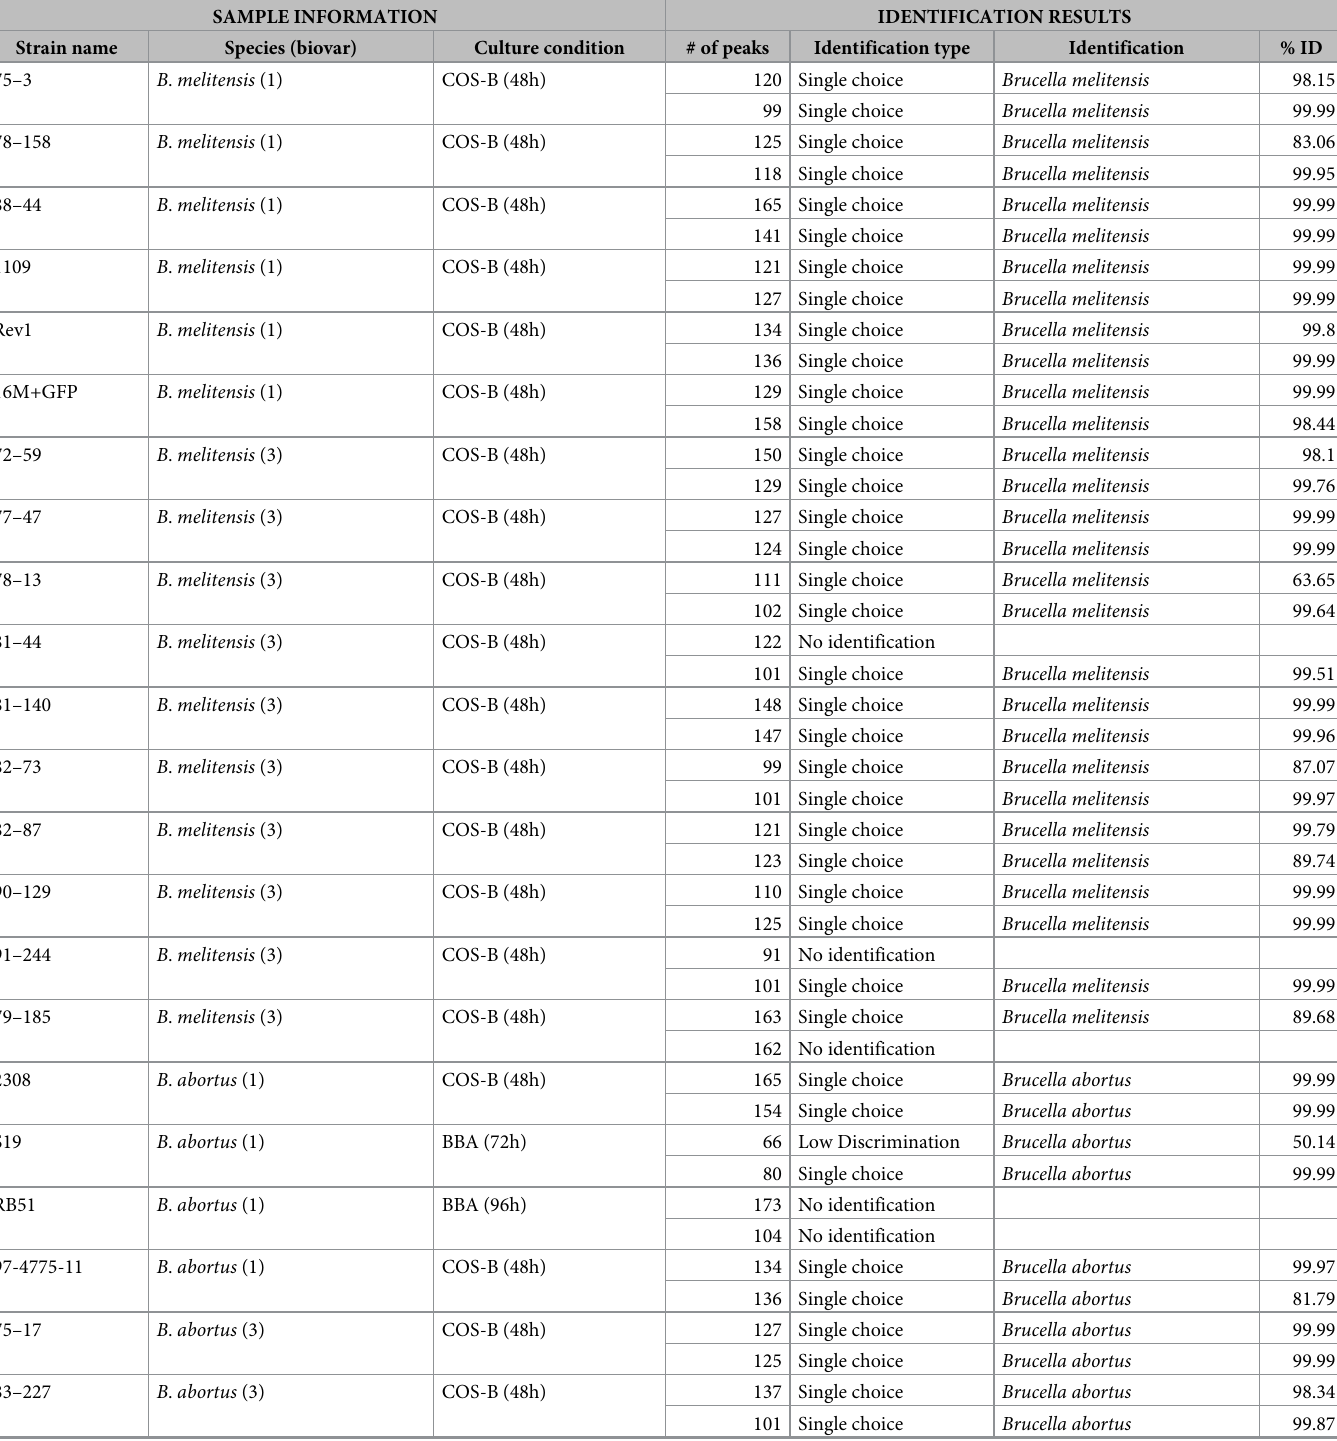
Table 5. Detailed results of external validation. For each strain, the identification results for the two deposits are given. %ID are confidence values given by the VITEK MS system for each identification result. COS-B = Columbia Blood Agar (bioMe´rieux, 43 041); BBA = Brucella blood agar (bioMe´rieux); COS-O = Columbia agar with 5% sheep blood (Oxo ï